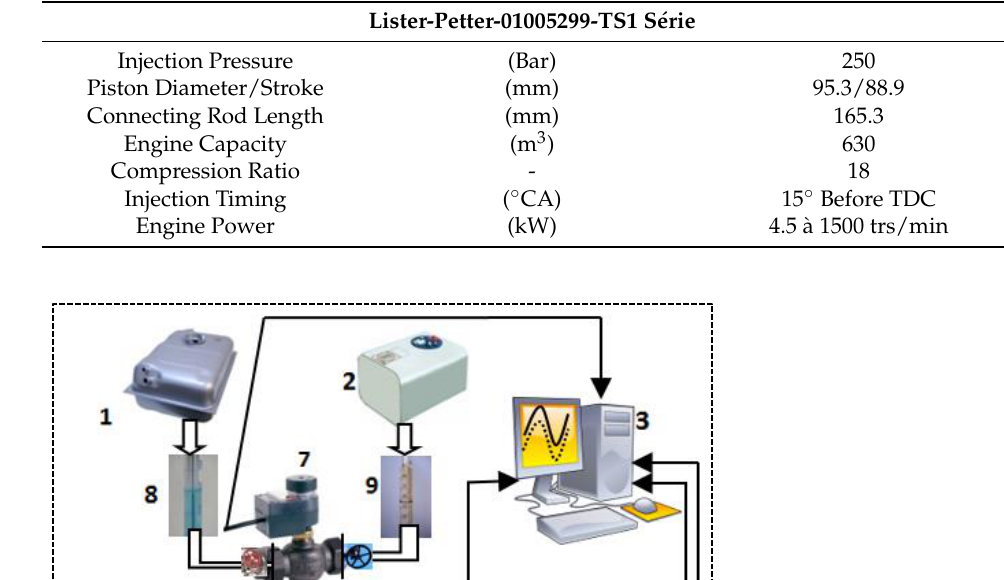
Table 1. Engine characteristics.